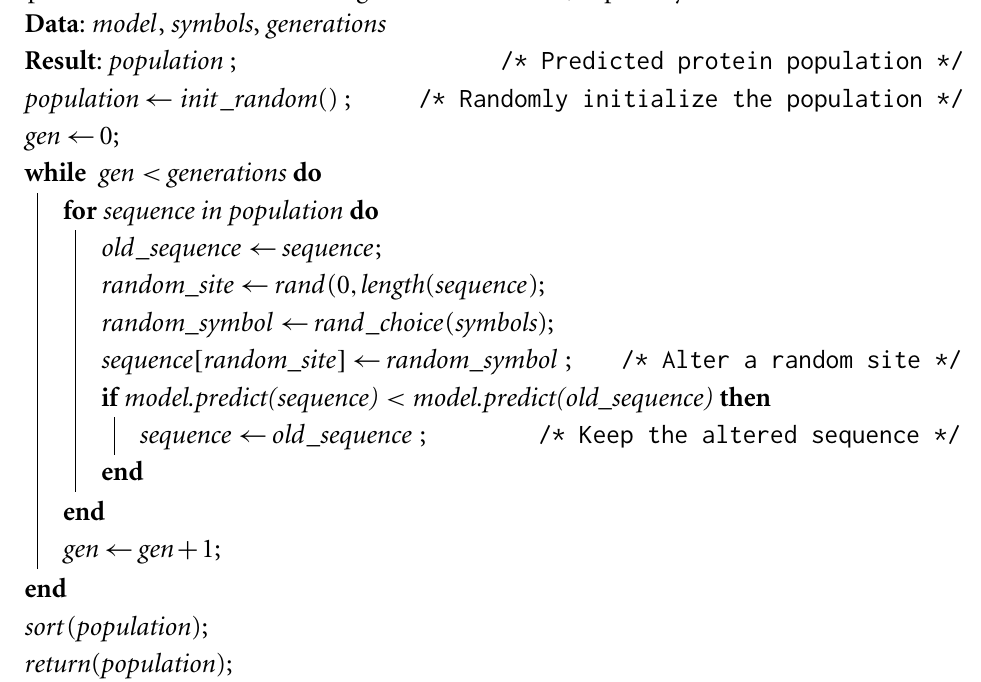
Algorithm 3: Evolving protein sequences using a trained Protein Optimization Engi- neering Tool sequence-function model. rand_choice() chooses a random element from a given list of elements. model.predict() predicts the fitness of a given protein sequence us- ing the best previously trained model. Starting from a random population of sequences increases the novelty in